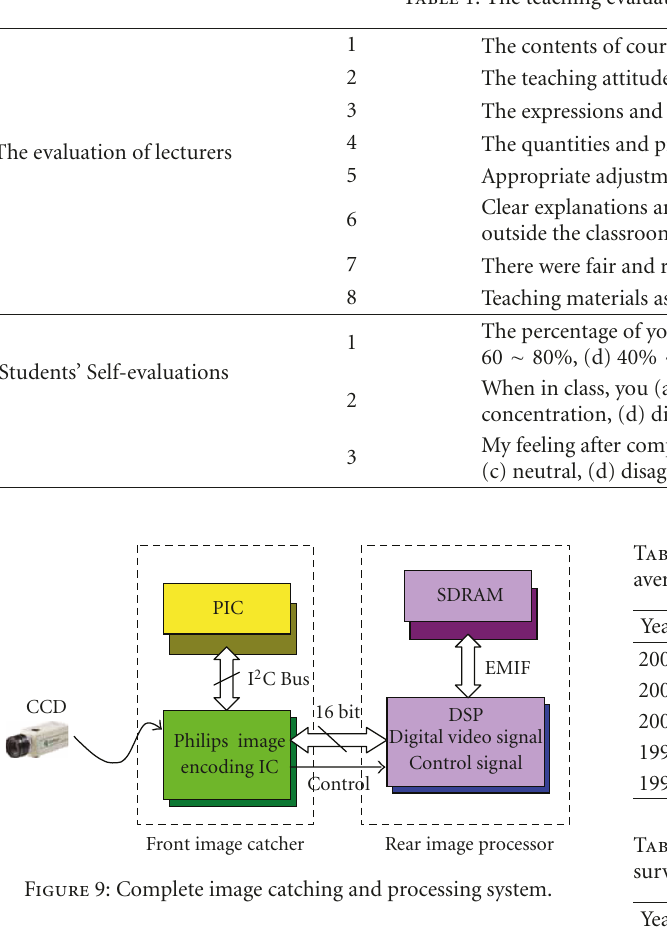
Table 1: The teaching evaluation survey form.